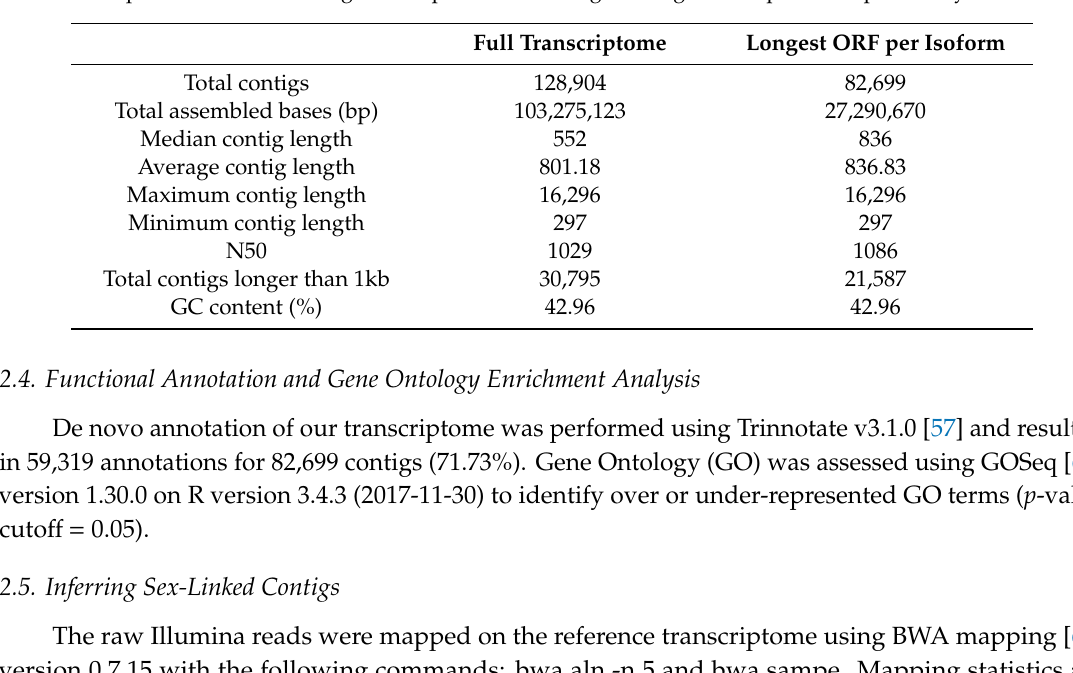
Table 1. Transcriptome assembly statistics of Coccinia grandis flower buds. Statistics in the final Trinity transcriptome and the working transcriptome containing the longest ORF predicted per Trinity